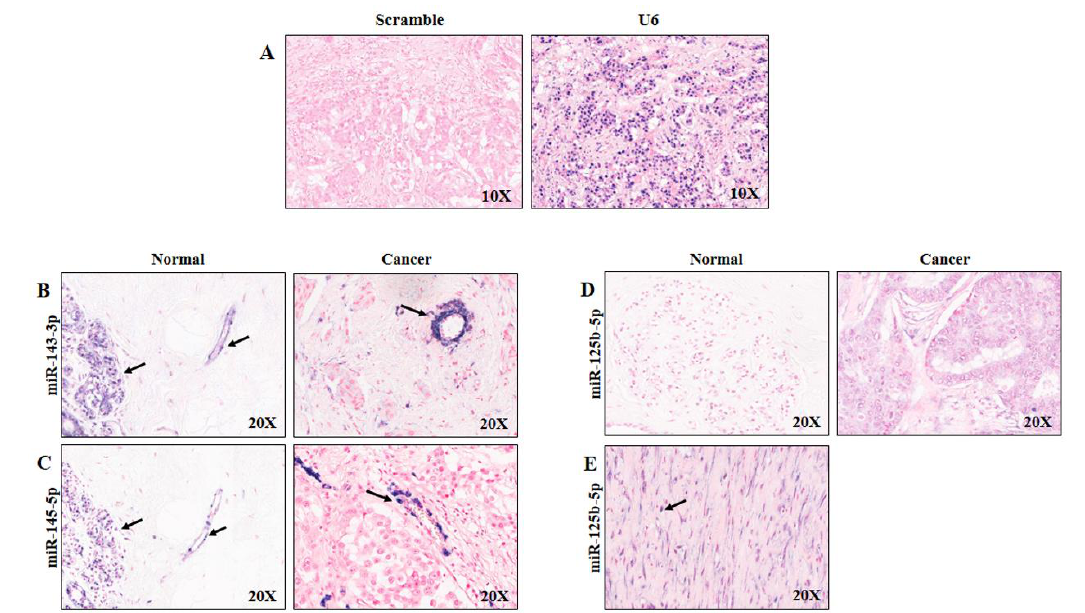
Figure 6. In situ hybridization staining patterns in benign and malignant breast tissues. Scrambled miR negative control probe and U6 positive control probe ( A ). miR-143-3p in normal (left) and BC tissues (right) ( B ). miR-145-5p in normal (left) and BC tissues (right) ( C ). miR-125b-5p in normal (left) and BC tissues (right) ( D ). miR-125b-5p in stromal tumour tissue ( E ). BC: breast